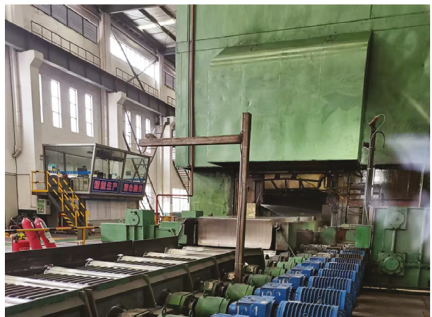
Figure 3: Experimental equipment applied in industry experiments.